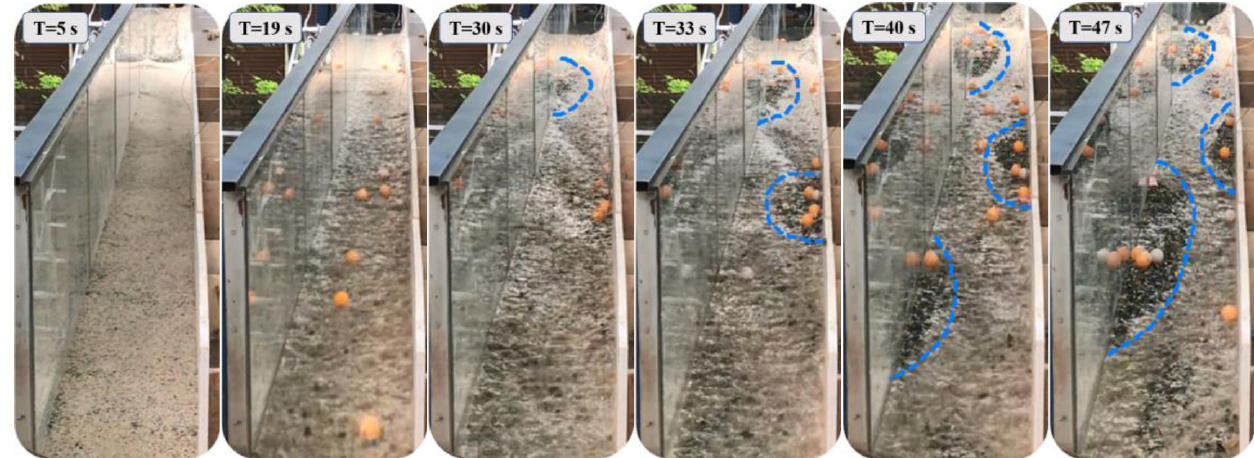
Figure 3. The riverbed morphology at six different moments during the boulder bars’ formations and growth process for the T7 experiment. The boulder bars in the figure are marked with blue dotted lines.